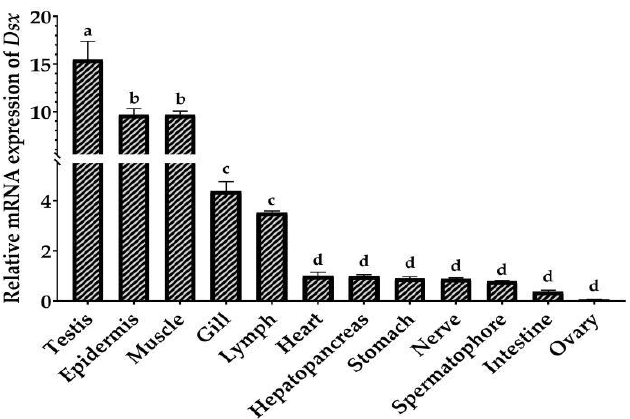
Figure 4. Relative expression of PmDsx in different tissues of P. monodon . Relative expression levels of PmDsx in 12 tissues were detected by qRT-PCR, the statistics were calculated by the 2 − ∆∆ Ct method, and expressed as mean ± standard deviation ( n ≥ 3). The same letters mean the difference is not significant, and different letters mean the difference is significant ( p ≤ 0.001).